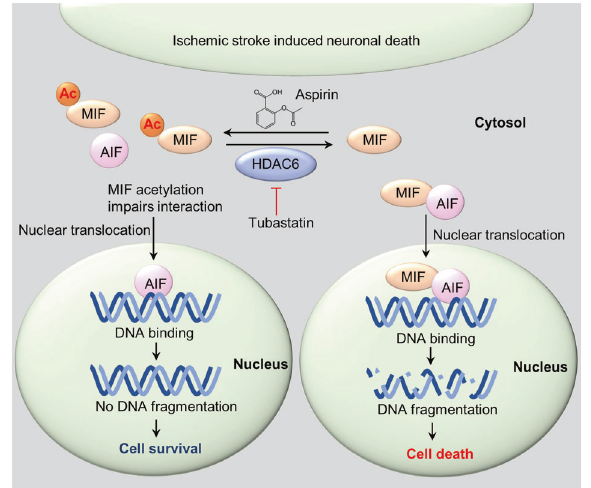
Fig. 7 Schematic model demonstrating the mechanism by which MIF K78 acetylation protects neurons from ischemic